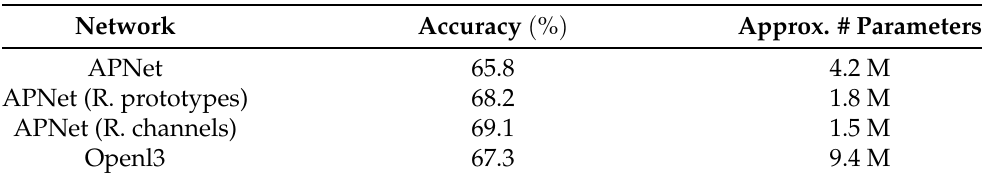
Table 4. The accuracy and number of parameters for APNet before and after the refinement processes for the Medley-solos-DB dataset. Openl3 is included as the most competitive